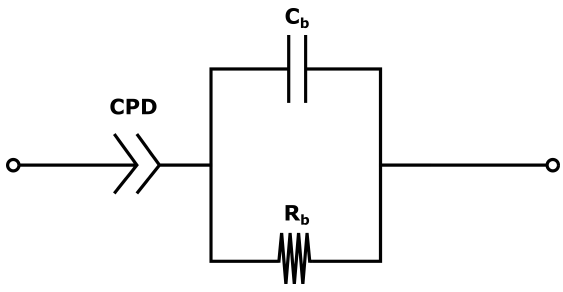
Figure 7. The equivalent circuit for a wet membrane between two electrodes.